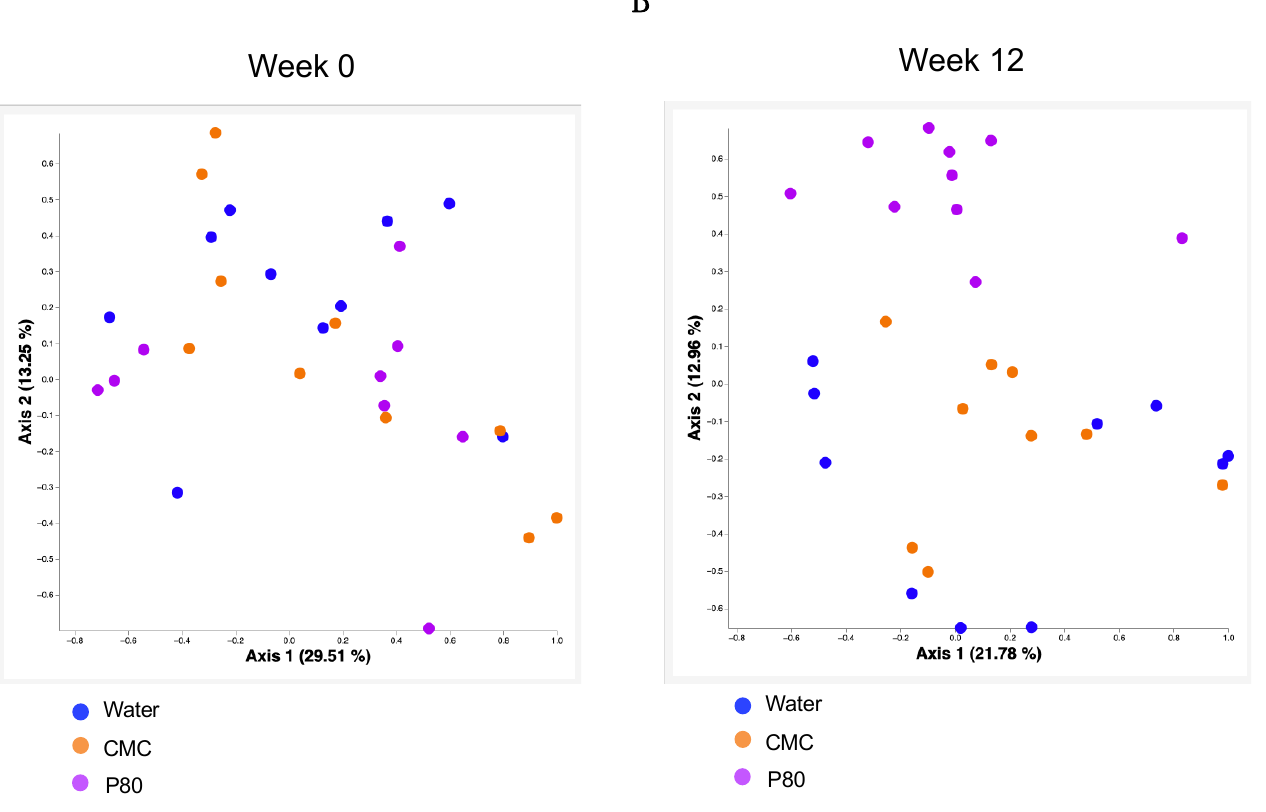
Figure 5. Alteration of microbiota in dietary emulsifiers treated mice with food allergy are expressed by Principal coordinates analysis (PCoA) plots to assess the variation among water, CMC, and P80 treated group at week 0 ( A ) and week 12 ( B ).